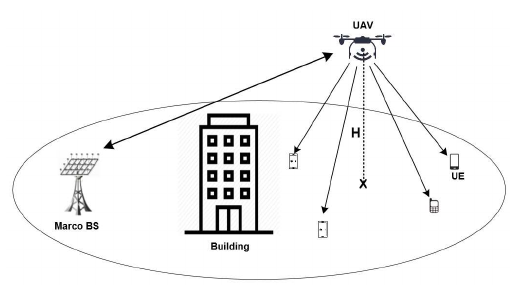
Figure 6. A relay network of an embedded